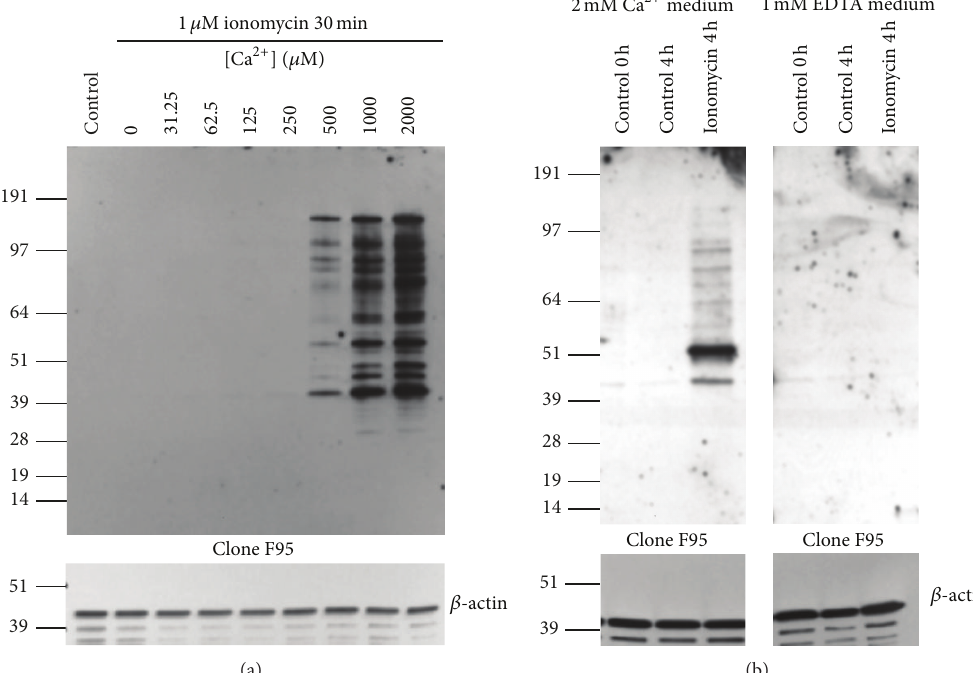
Figure 3: Neutrophil hypercitrullination requires extracellular calcium. (a) Freshly isolated neutrophils were cultured in medium with 2mM CaCl 2 alone or in medium with the indicated concentrations of calcium and 1 𝜇 M ionomycin for 30 min. Citrullination was detected with the clone F95 antibody (upper panel) and equal loading verified with anti- 𝛽 -actin (lower panel). (b) Neutrophils were incubated in medium with 2 mM CaCl 2 (left panel) or with 1mM EDTA (right panel) alone for 0 or 4 hours or with 1 𝜇 M ionomycin for 4h. Citrullination was detected with the F95 antibody (upper panel) and equal loading verified with anti- 𝛽 -actin (lower panel). Results are shown from one donor representative of three different